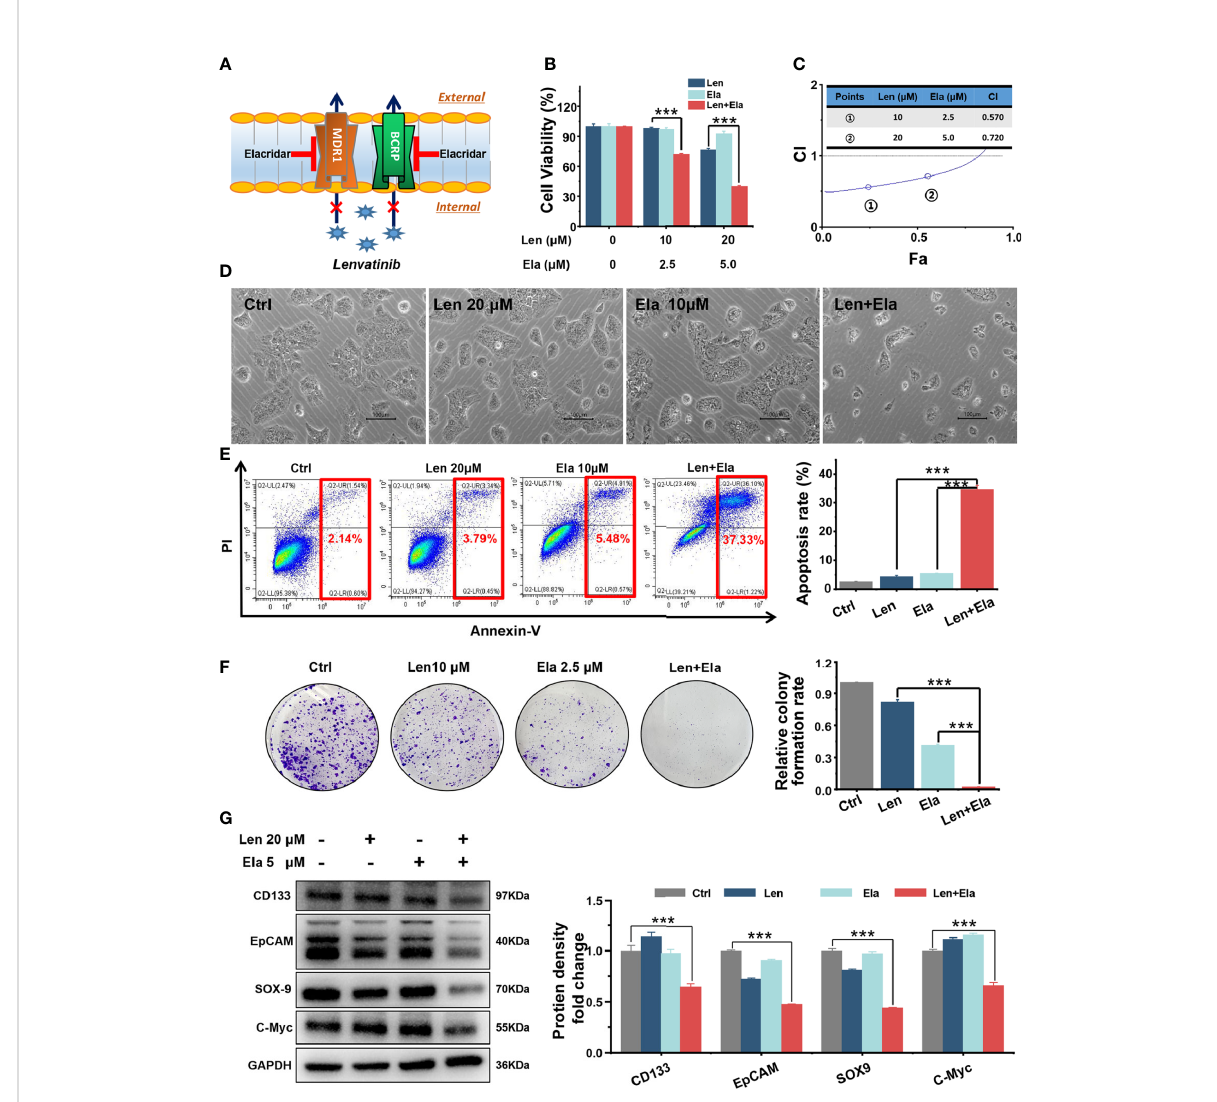
FIGURE 4 In vitro combined antitumour effect of lenvatinib and elacridar. (A) Schematic diagram indicates that elacridar dually inhibited MDR1 and BCRP. (B, C) The MTT results and CI plots con fi rmed that elacridar synergised with lenvatinib to inhibit Huh7 LR cell viability. (D, E) Co-treatment with elacridar and lenvatinib enhanced cell apoptosis, as shown in micrographs and fl ow cytometry plots. (F, G) Combined elacridar and lenvatinib treatment inhibited colony formation and downregulated CD133, EpCAM, SOX-9, and c-Myc expression. *** p <